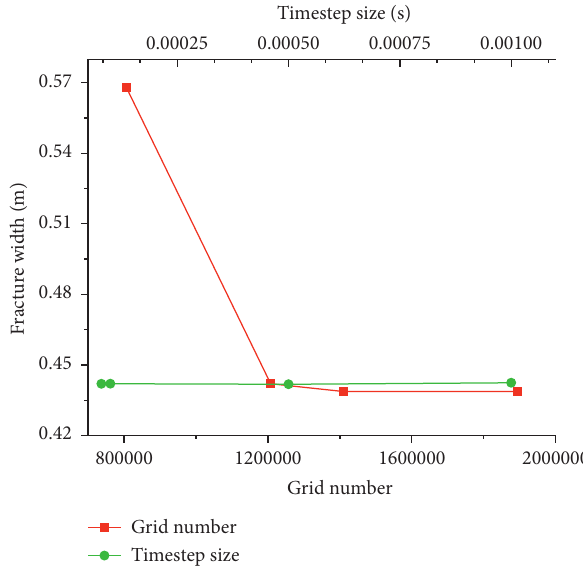
Figure 5: Grid independence and time independence verification diagram. Table 6: Variation of fracture width with grid number and